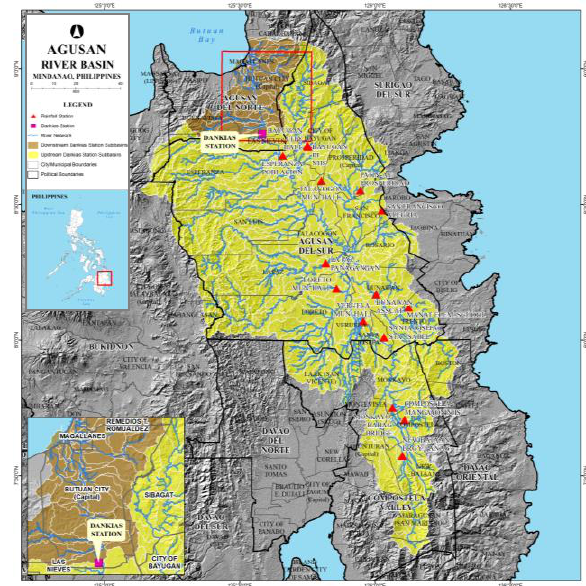
Figure 1. The Agusan River